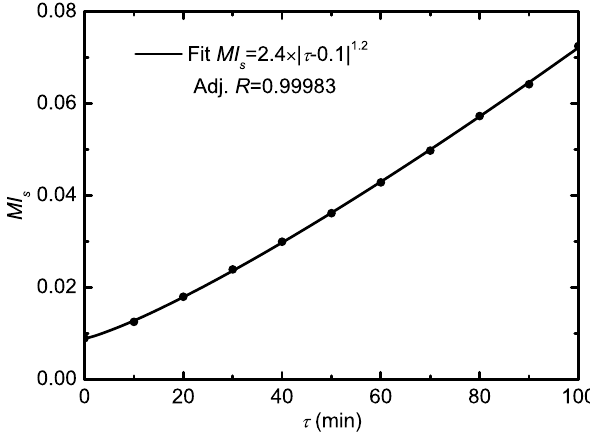
Figure 4. Mutual information (MI) in steady state as a function MI ( P , M , t ) . The fit function and its of time delay t , where MI s ~ lim t ? ? adjusted R -Square are indicated. The parameters are as in Fig. 1.